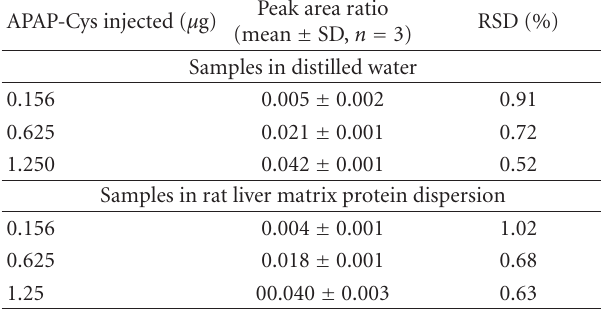
Table 2: Results of the intraday variability study on the proposed HPLC method based on three di ff erent concentrations of APAP- Cys added to distilled water and to blank rat liver matrix protein dispersion a,b . Peak area APAP-Cys injected ( µ g)